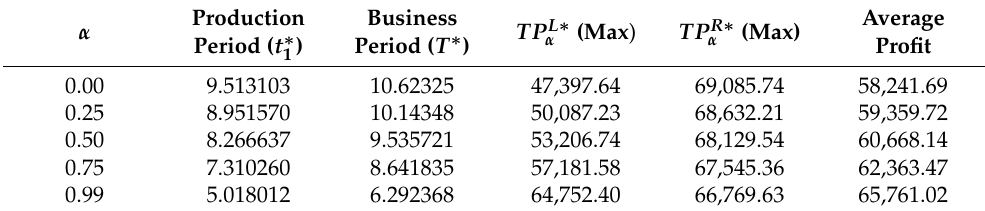
Table 10. Optimum results of Example 3 for maximizing both TP L α and TP R α